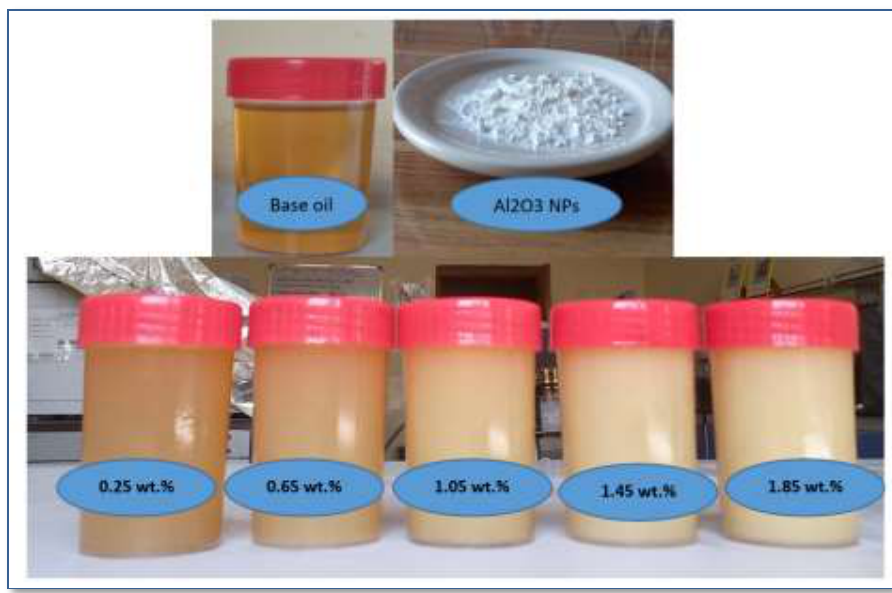
Figure 8: Testing nano-lubricants stability for 60 days at different Al 2 O 3 NPs additions.